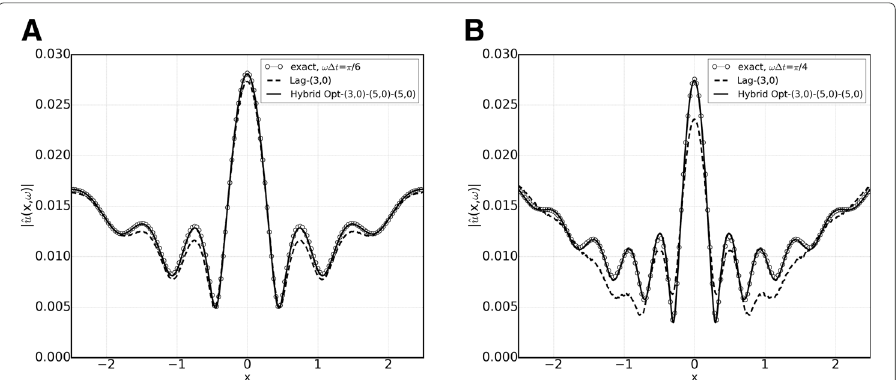
Fig. 6 Frequency domain solution along a field line r = ( x ,0, − 2.5 ) for − 2.5 ≤ x ≤ 2.5. Shown are the computational results by using the traditional Lag-(3,0) and the hybrid scheme Opt-(3,0)-(5,0)-(5,0) schemes. Also shown is the analytic solution for comparison. ( a ): ω(cid:4) t = π/ 6; ( b ): ω(cid:4) t = π/